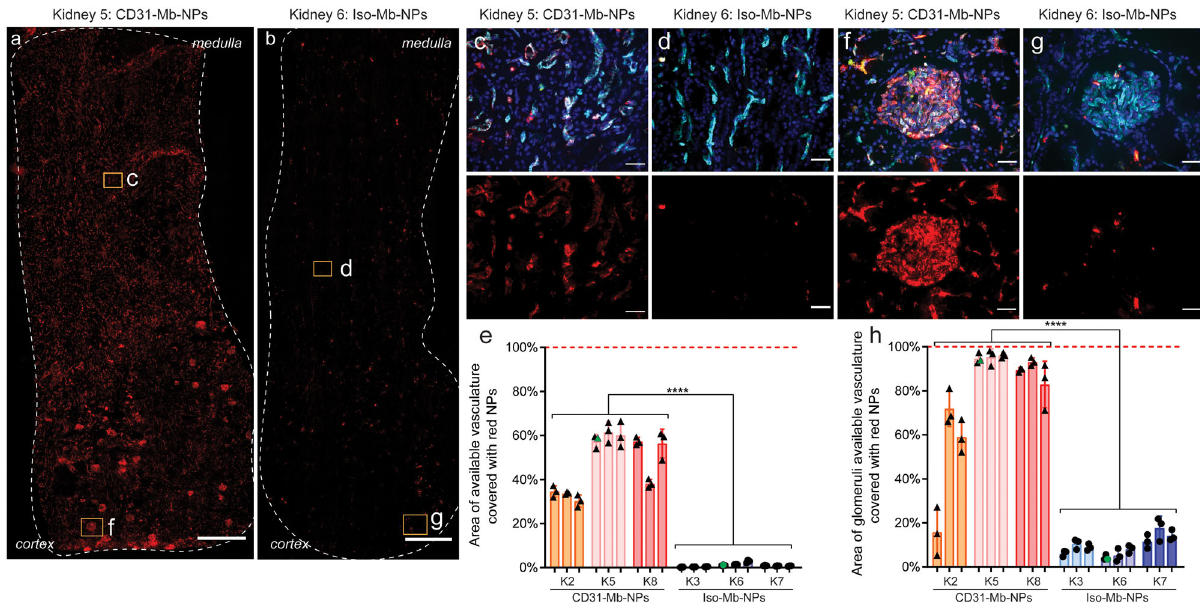
Fig.5|CD31-Mb-NPsspeci fi callyandef fi cientlyaccumulatethroughouthuman renal endothelium during ex vivo organ perfusion. a , b Representative kidney biopsyslices(10 µ mthickness)takenfromorgansaftera4hexvivoperfusionwith either CD31-Mb-NPs ( a ) or Isotype (iso)-Mb-NPs ( b ). Images show nanoparticles (NPs) in red with high levels of accumulation throughout the biopsy sample when NPsare targeted using CD31 ( a ). The biopsy perimeter isoutlined in white,and the cortex- and medulla-facing-ends are labeled for orientation. Yellow boxes outline the location of the high magni fi cation images de fi ned in the rest of the fi gure and arelabeledwiththecorrespondingletter.Scalebaris1mm. c , d , f , g Representative high magni fi cation images of microvasculature and glomeruli display NPs in red, vascular cells in cyan, cell nuclei in dark blue, and untargeted NPs in green. Each image is displayed with a color-merged view and accompanied with a red-only image below. Scale bar is 50 µ m. Kidneys perfused with CD31-Mb-NPs have much